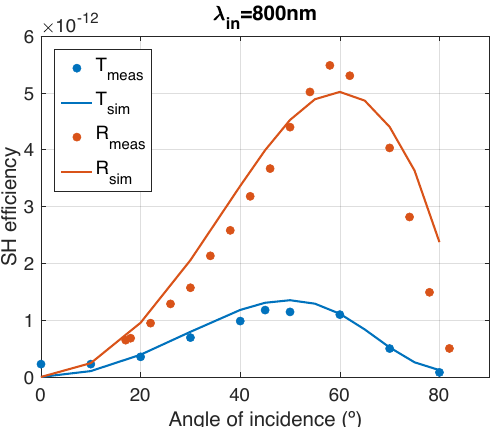
Fig. 2. Measured (full circles) and predicted (solid curves) SHG efficiencies as a function of the angle of incidence from the 20nm-thick Au layer when the incident pulse is tuned at 800nm. Transmission and reflection are plotted in blue and red, respectively.